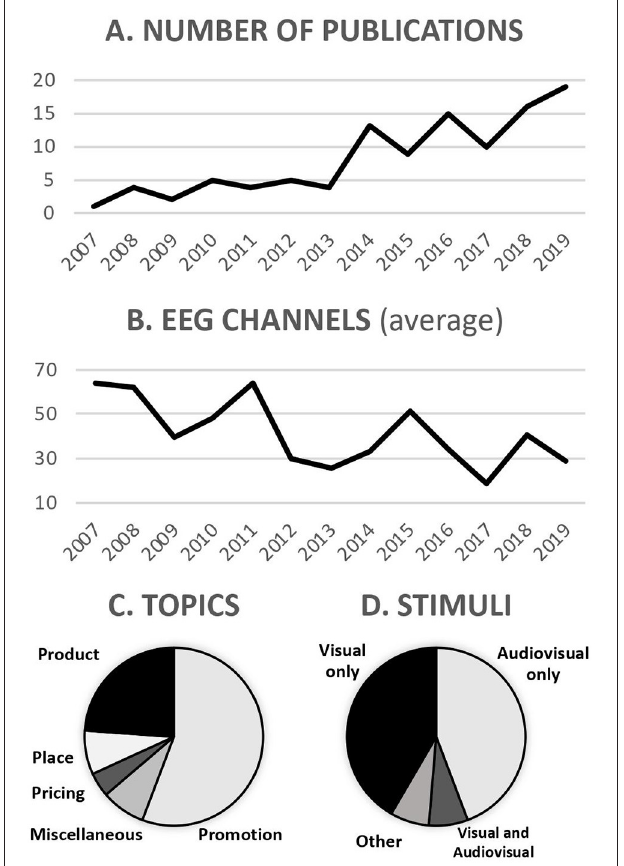
FIGURE 4 | Literature review. (A) Number of publications between 2007 and 2019. (B) Average number of EEG channels between 2007 and 2019. (C) Distribution of research topics. (D) Distribution of stimuli used. Visual indicates static visual stimuli (e.g., picture), audiovisual indicates dynamic stimuli (e.g., commercial).